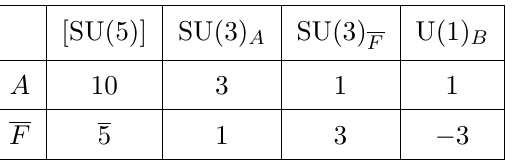
Table 1 . Matter content of the three-generation SU(5) chiral gauge theory. Here and throughout we use square brackets [SU(5)] to denote gauge